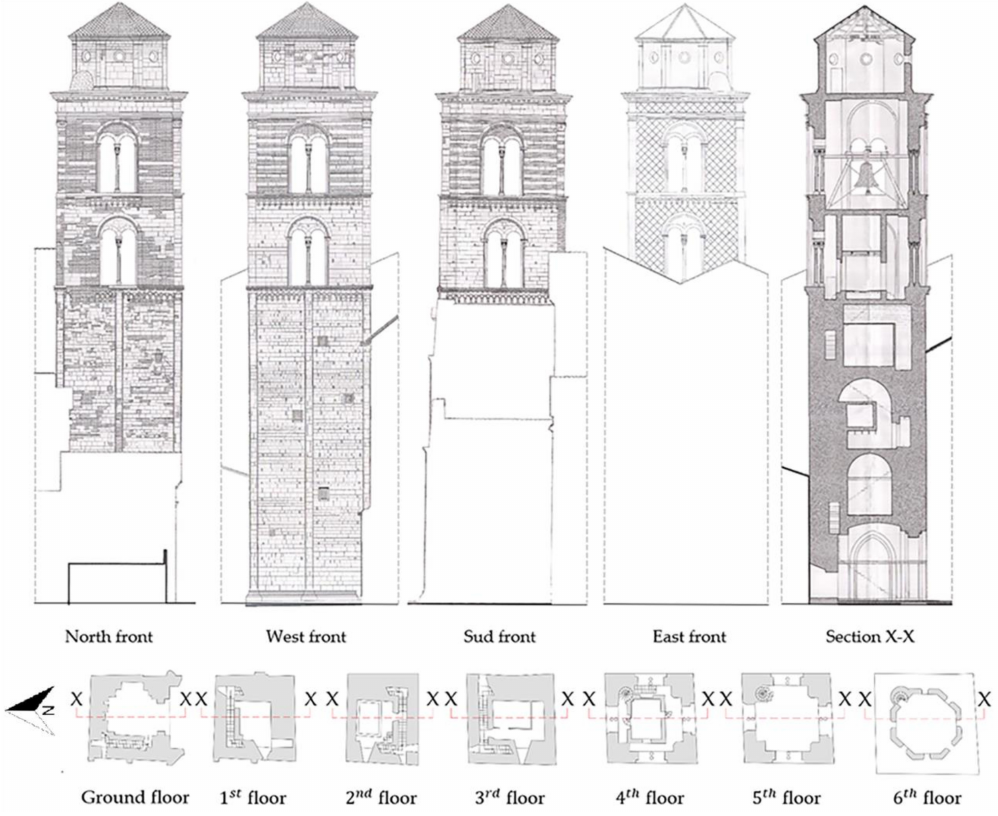
Figure 2. Geometrical features of the bell